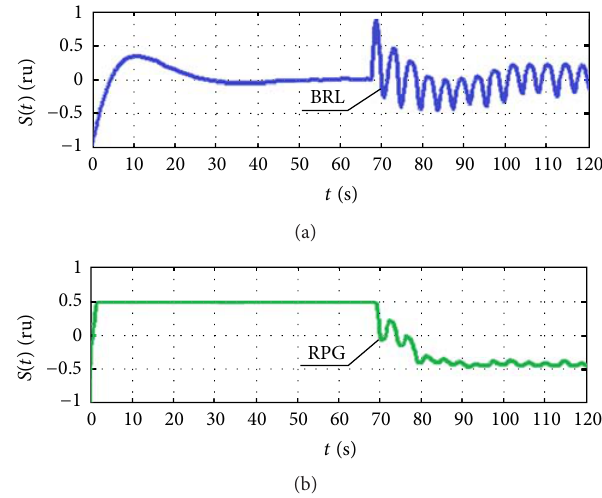
Figure 2: Typical BRL and RPG signals for breath holding episode ((a): BRL signal; (b): RPG